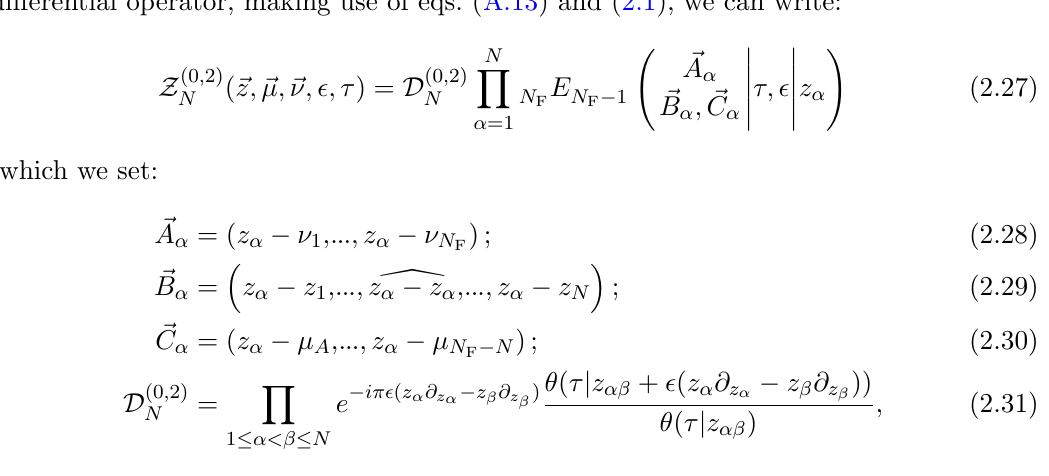
= 2, U( N ) gauge theory with N F N